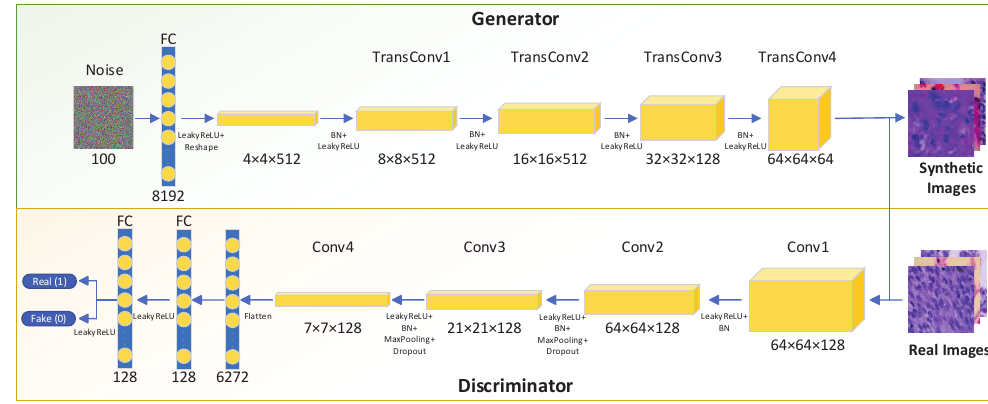
Figure 2. The overall architecture of proposed LCGAN.